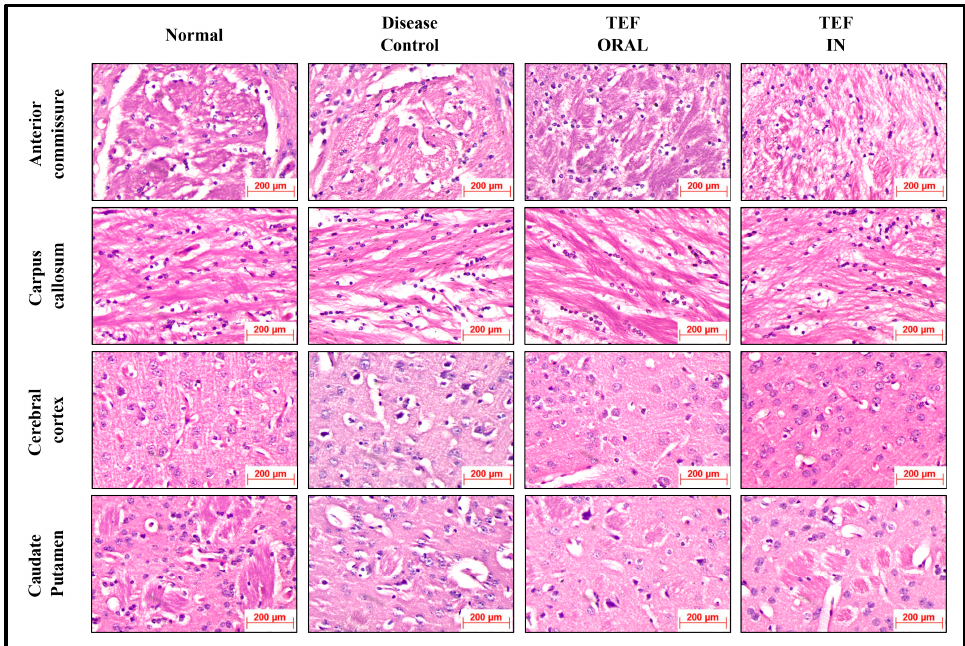
Figure 6. The H&E-stained coronal sections of the Normal, Disease Control, TEF oral, and TEF IN treatment groups (400×).